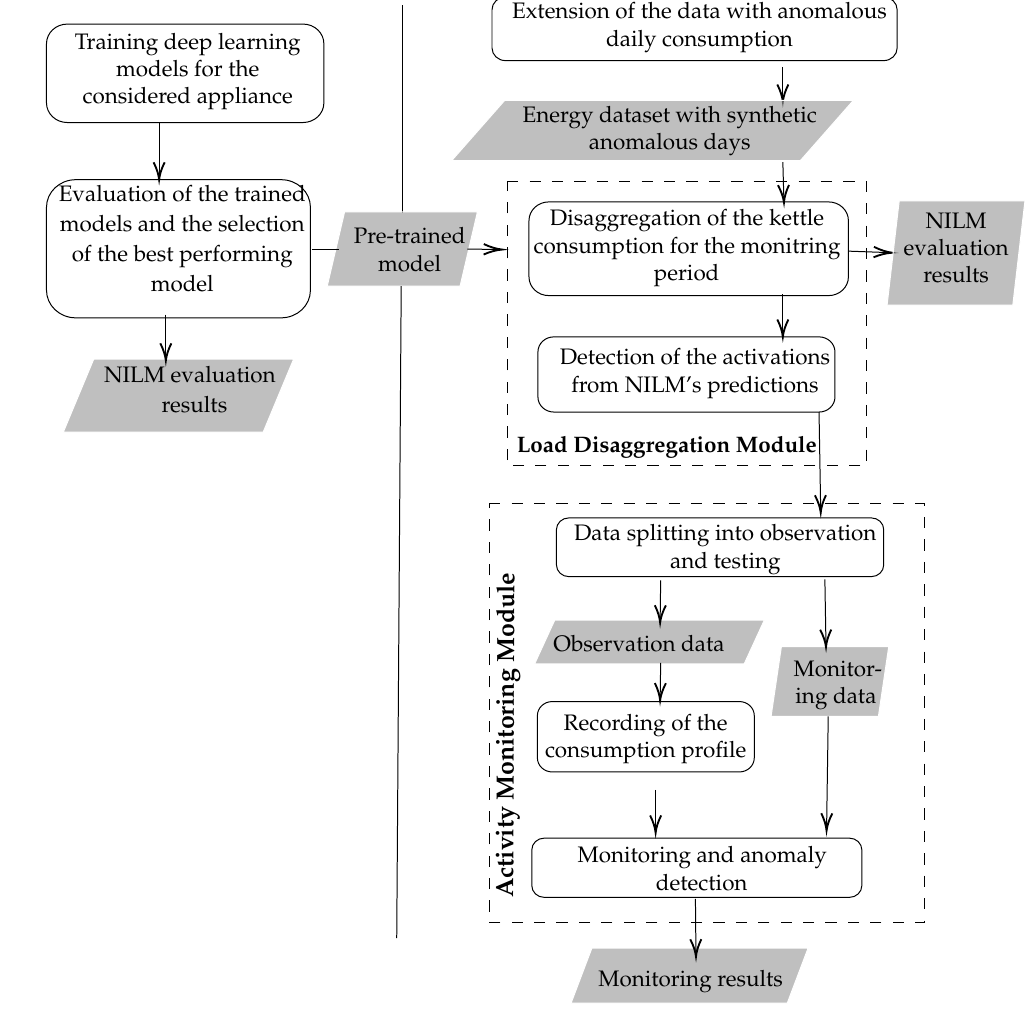
Figure 3. The evaluation